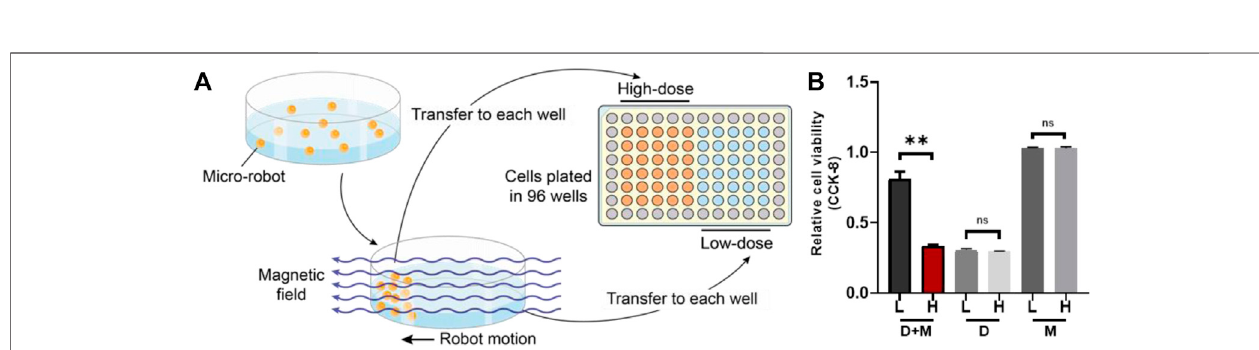
FIGURE 5 | The simulation of selectively drug inhibition of microrobots in vitro . (A) The sketch map of simulation. Most of the microrobots were driven by the magnetic fi eld to one side of the culture dish and then the liquid was added to both sides (low-dose and high dose sides of microrobots) in the 96-well plate culturing HOS/MNNG tumor cells. (B) A lower cell viability was detected in the high dose of microrobots (**: p < 0.01). L, Low-dose; H, High-dose; D + M, Microrobots with EPZ015666; D, Dissociative EPZ015666; M, Drug-free microrobots.